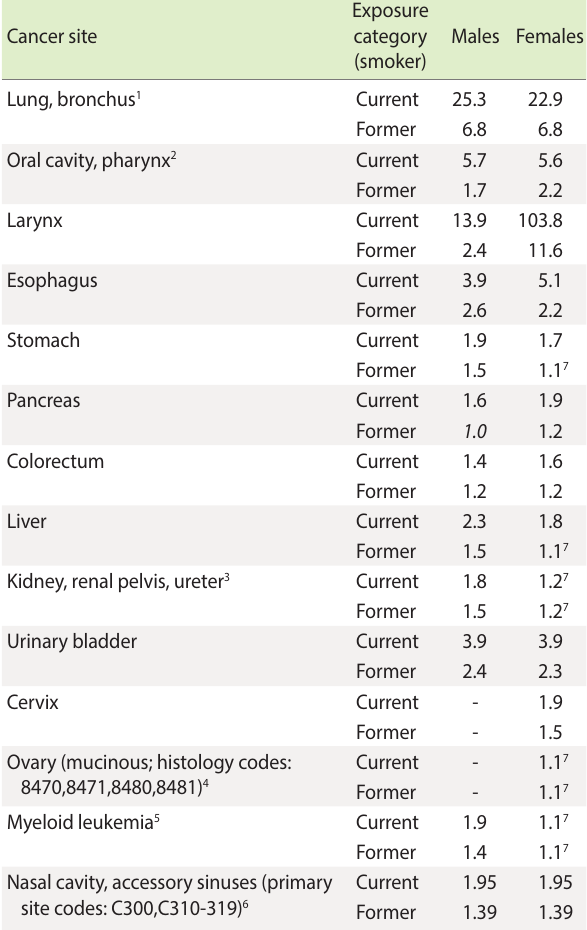
Table 1. Relative risks (RRs) associated with smoking by status (cur- rent vs. never-smokers, former vs.